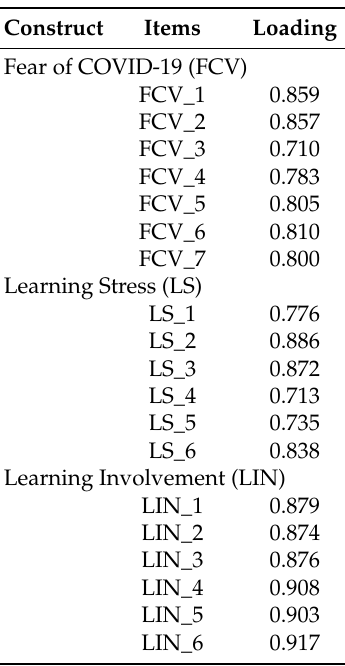
Table 2. Results of reliability and convergent